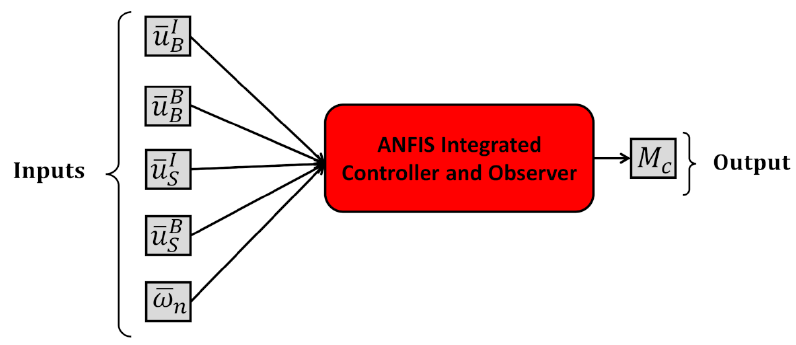
Figure 5. Block diagram of the integrated ANFIS controller and